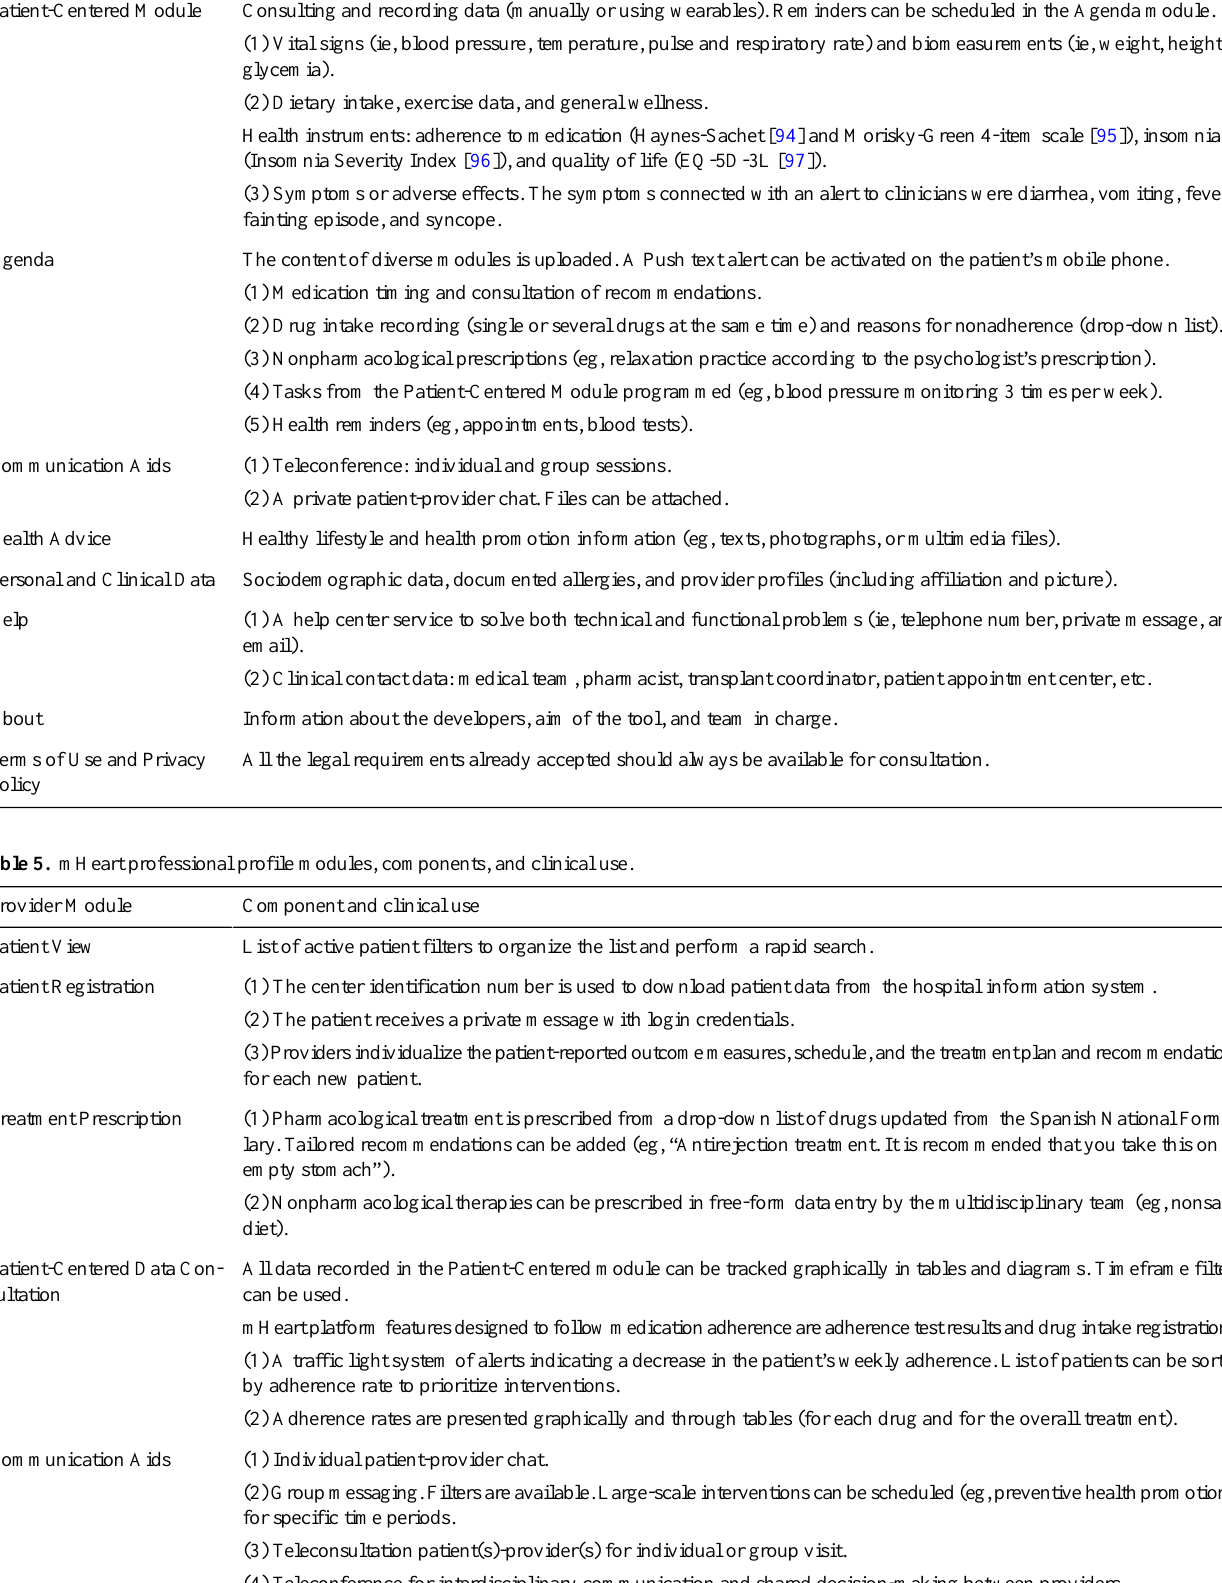
Table 4. mHeart patient profile modules, components, and clinical use. Components and clinical usePatient module Medication list including information on inactive drugs.